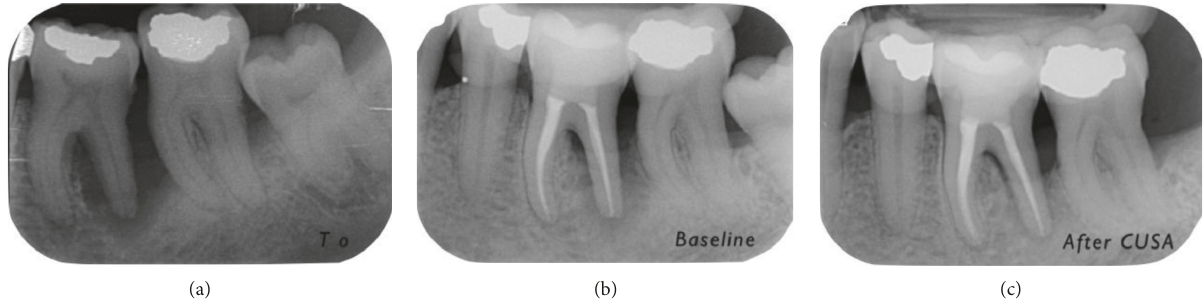
Figure 6: Progression of X-rays showing bone remineralization. Baseline is 12 months after (a) T0. In this case, the PD decreased from 10mm ((b) baseline) to 4mm (6 months (c) after CUSA treatment). The CAL gain was 7 mm (from 15 mm to